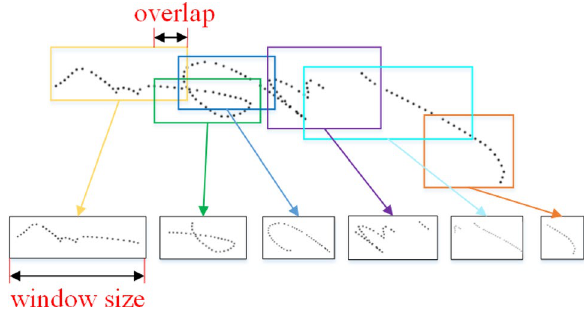
Figure 10. Trajectory image framing example.